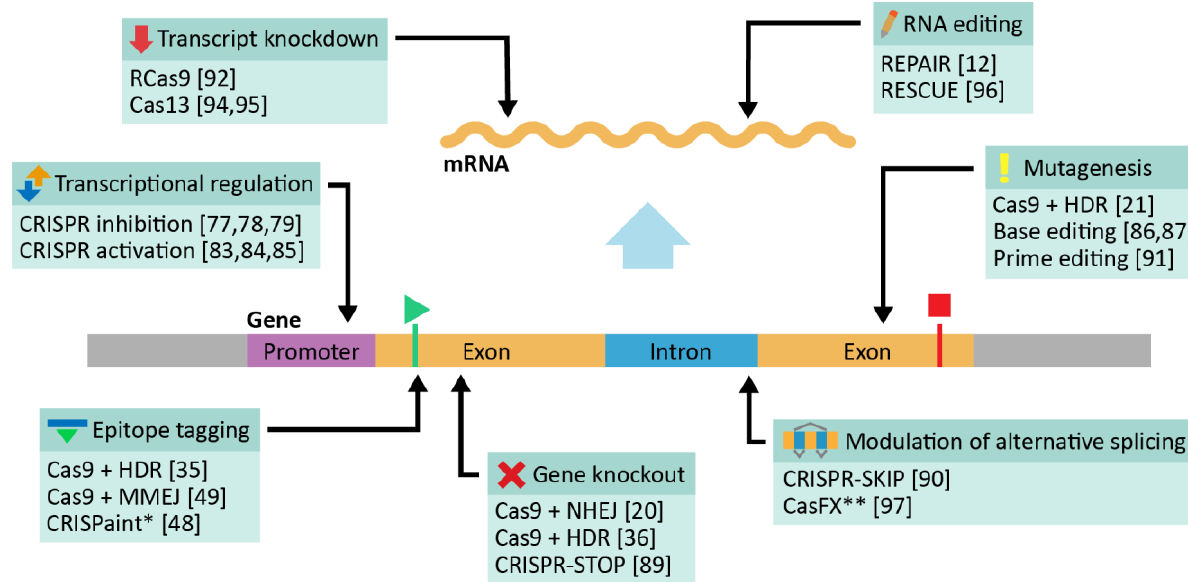
Figure 1. Applications of CRISPR-Cas. Note that illustrated locations and applications of CRISPR-Cas editing are not exhaustive. * CRISPaint only supports C-terminal tagging, but is otherwise similar to other methods of epitope tagging. ** CasFX acts at the level of pre-mRNA rather than DNA.